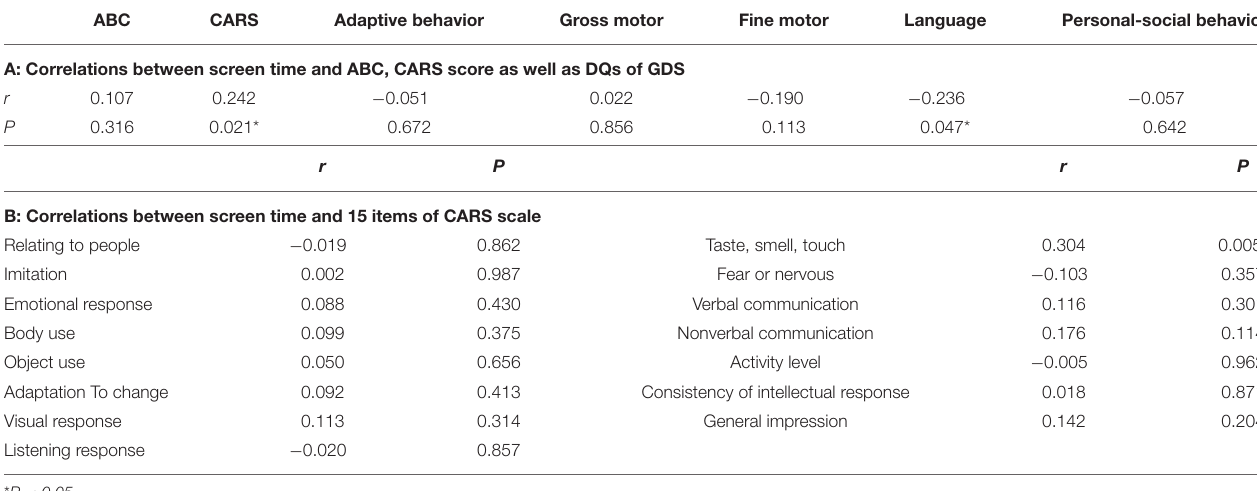
TABLE 2 | Correlations between screen time and ASD symptoms and development quotients. ABC CARS Adaptive behavior Gross motor Fine motor Language